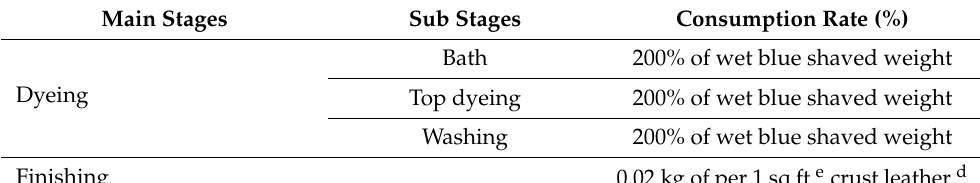
Table 1. Cont. Main